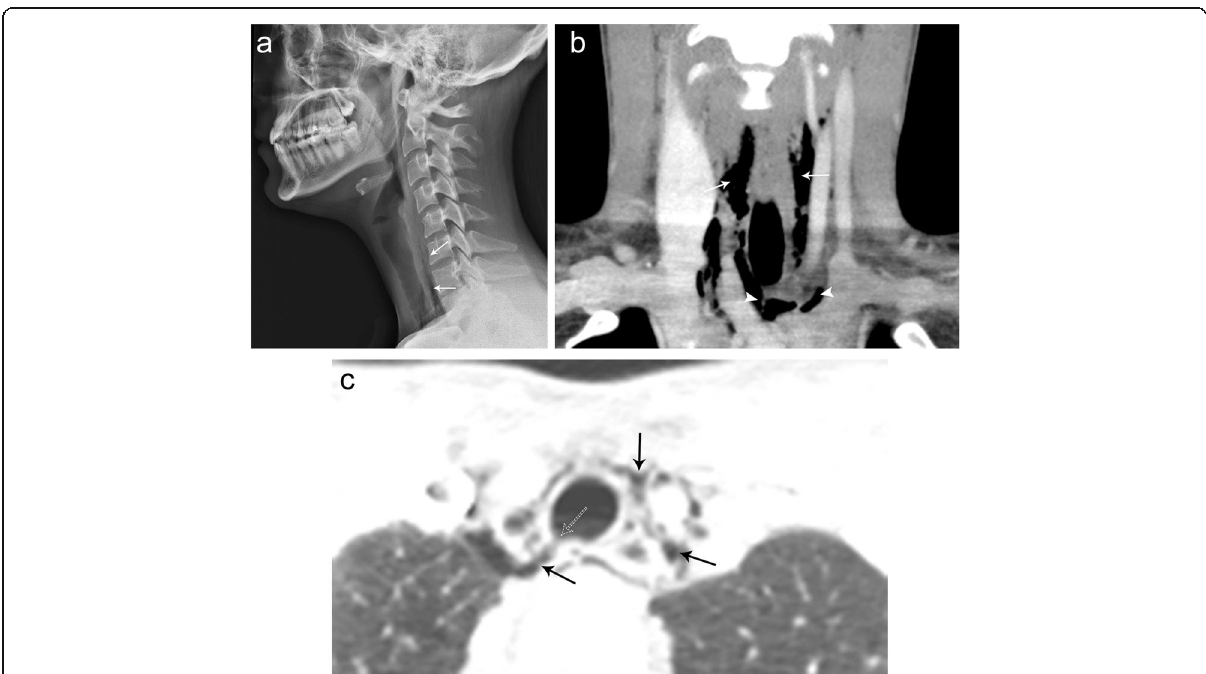
Fig. 23 Subcutaneous emphysema and pneumomediastinum. Lateral cervical spine radiograph ( a ) showing linear streaks of air (arrows) tracking along the prevertebral soft tissues of the thoracic inlet consistent with subcutaneous emphysema. Coronal ( b ) contrast CT image demonstrates subcutaneous air (arrows) tracking along the cervical soft tissues and fascial planes extending into the superior mediastinum (arrowhead). Axial CT chest image in lung ( c ) windows demonstrating air (solid arrows) within fascial planes of the superior mediastinum. Note the tracheal defect (dashed arrow) which was the source of the pneumomediastinum and subcutaneous emphysema on the lung window